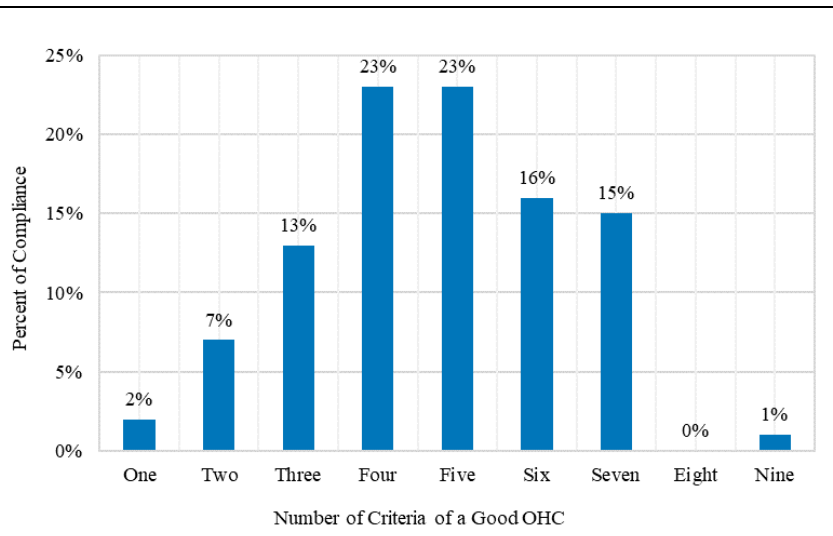
Figure 3. Percentage of compliant websites and the number of reliability criteria.